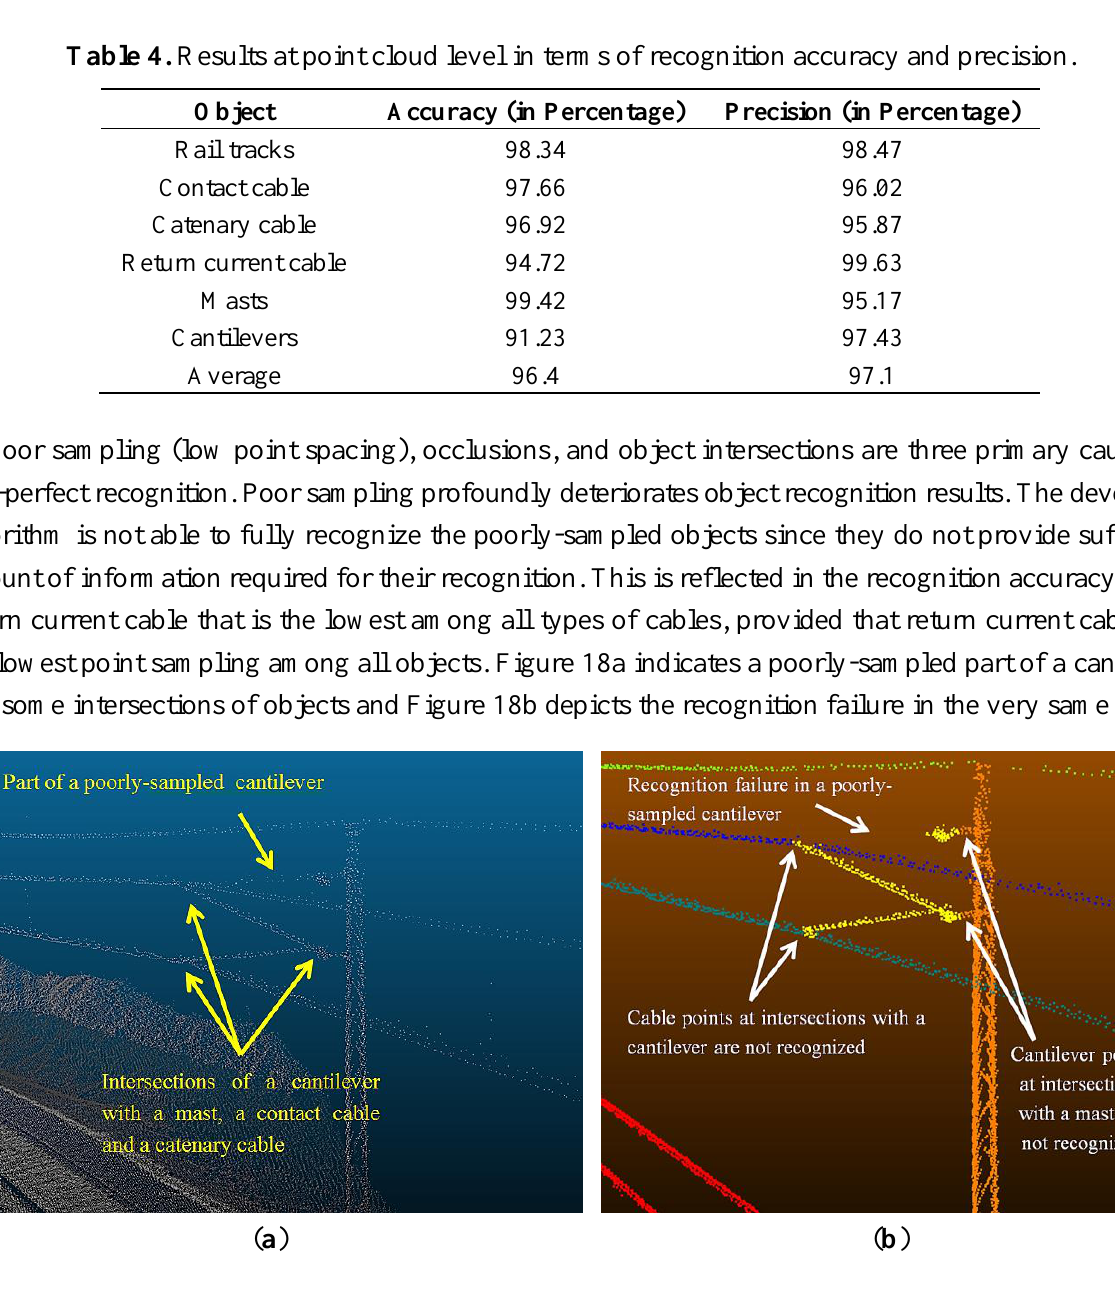
Figure 18. ( a ) Some instances of poor sampling, occlusion, and object intersection in the dataset; ( b ) Object recognition results in the very same